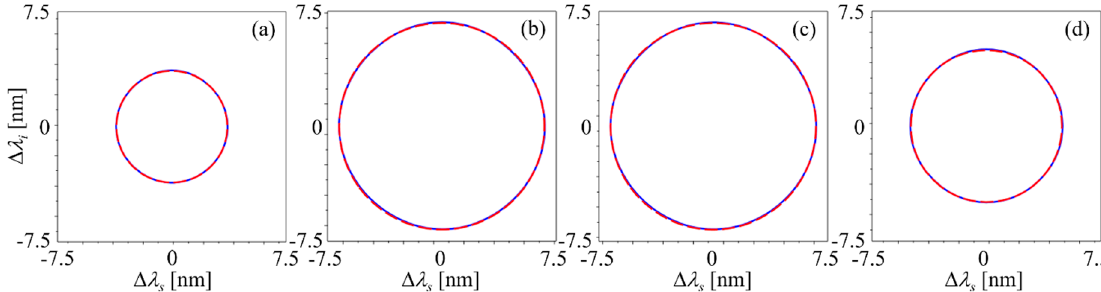
Figure 8. Contour lines for JSI = 0.5 (blue solid lines) for the cases shown in Figure 7: ( a ) RTP, ( b ) RTA, ( c ) KTA, and ( d ) CTA. The red dashed lines represent the circles with diameters of 7.35 nm, 13.6 nm, 13.6 nm, and 10 nm, respectively. Each result was calculated for a crystal length of 10 mm.